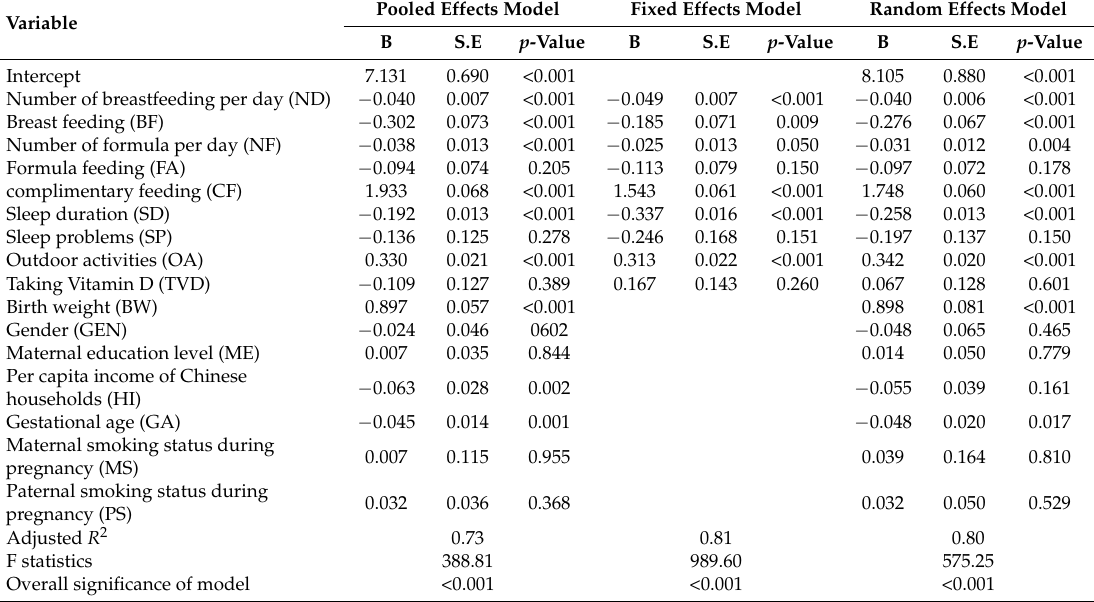
Table 5. Results of relationship between infant sleep and their weight based on the panel data models (According to a longitudinal community-based retrospective birth cohort study conducted in Changsha in